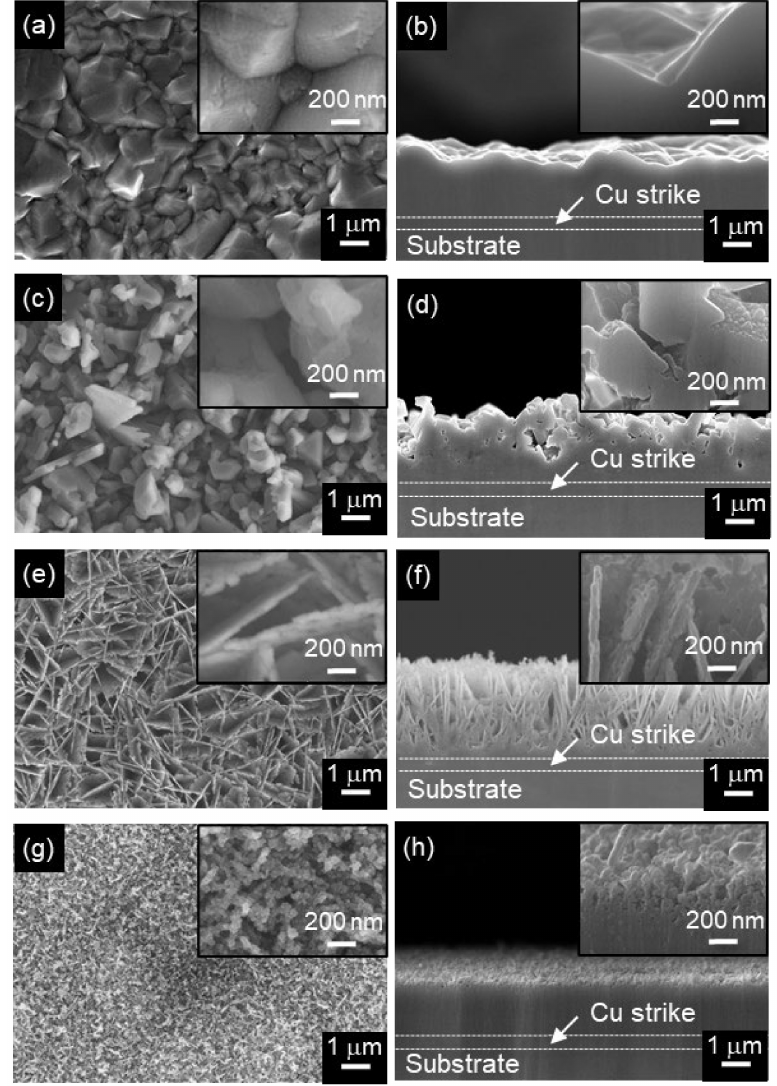
Figure 4. Surface ( left ) and cross-sectional ( right ) SEM images of roughened electrodeposited copper films from plating baths containing different concentrations of PAA: ( a , b ) 0 M; ( c , d ) 5 × 10 − 5 M;